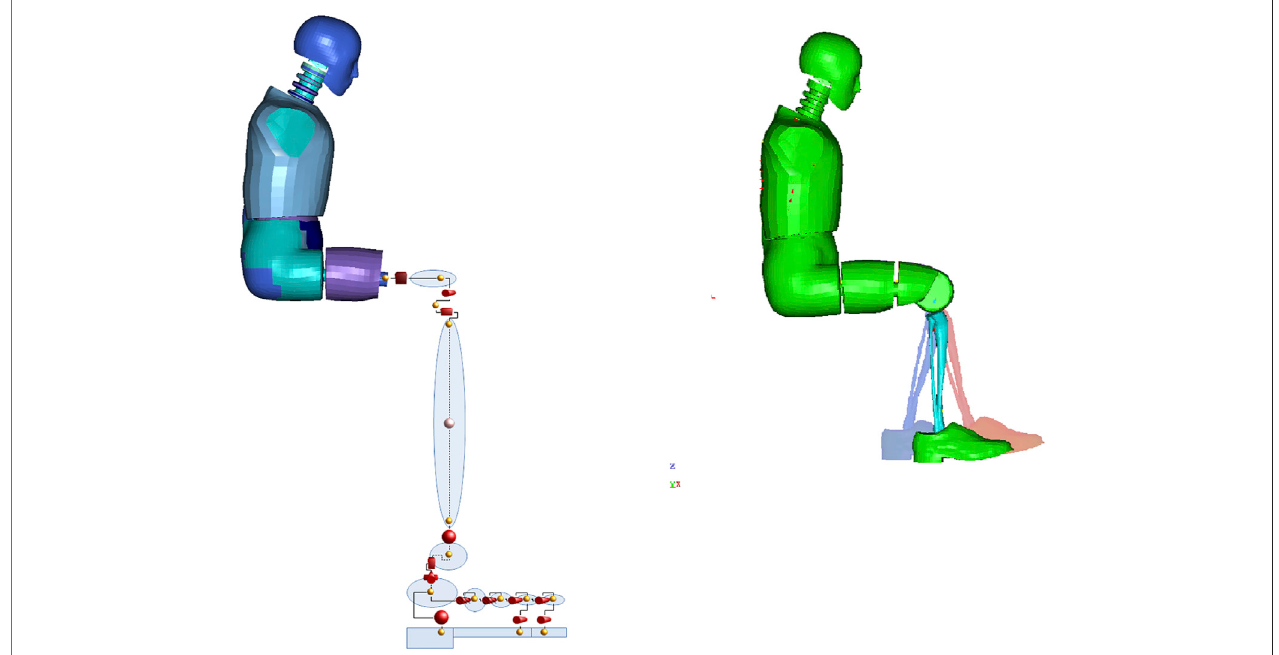
FIGURE 3 | Model structure and model with geometry representation (visualization of positions 75 ° and 105 ° — blue, 90 ° and 90 ° , and 105 ° and 5 ° — red).